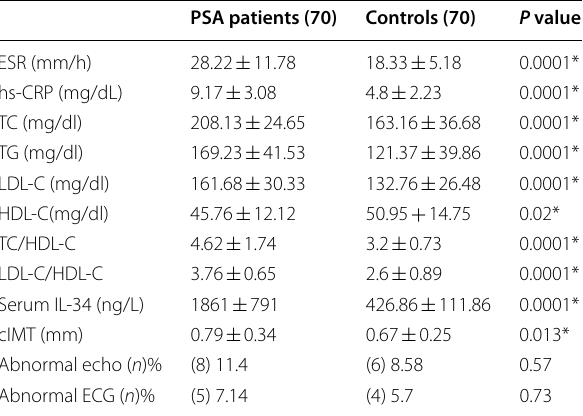
PSA psoriatic arthritis, ESR erythrocyte sedimentation rate, hsCRP highly sensitive C-reactive protein, TC total cholesterol, TG triglycerides, LDL-C low-density lipoprotein cholesterol, HDL-C high-density lipoprotein cholesterol, IL-34 interleukin-34, cIMT carotid intima media thickness, ECG electrocardiogram Significant value*: P <